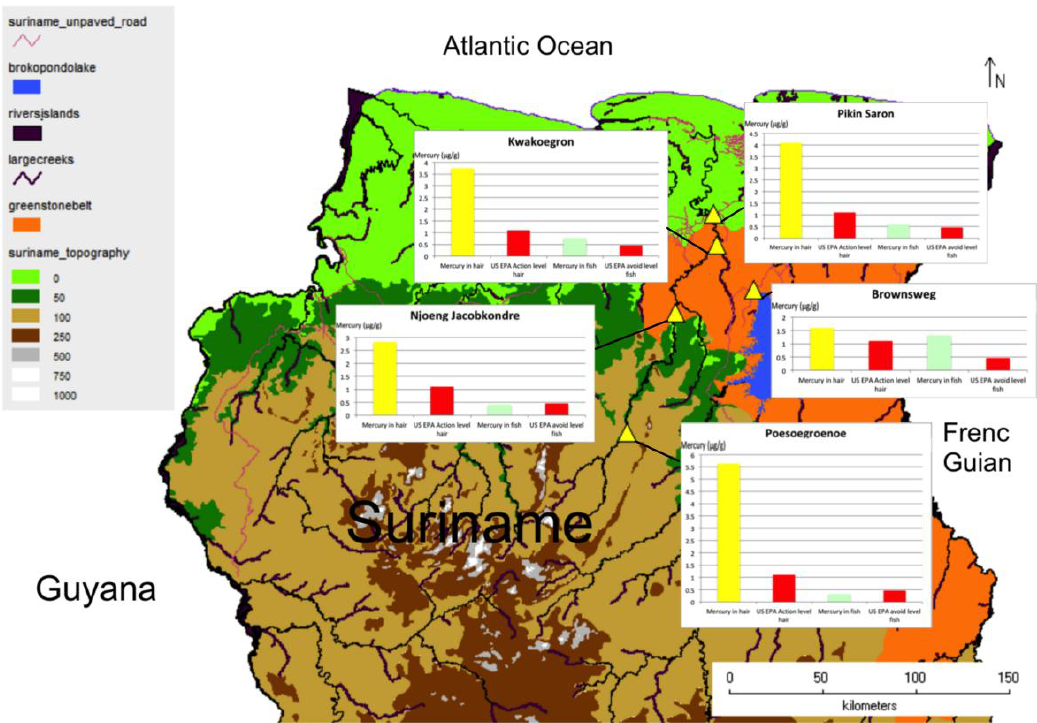
Figure 1. Map of the northern and central part of Suriname, showing study area and villages that have participated in the research (yellow triangles). Mercury levels in hair and fish are included to facilitate comparison. The Greenstone Belt (in orange) is the area where artisanal and small-scale gold mining (ASGM) activities are concentrated and ongoing.